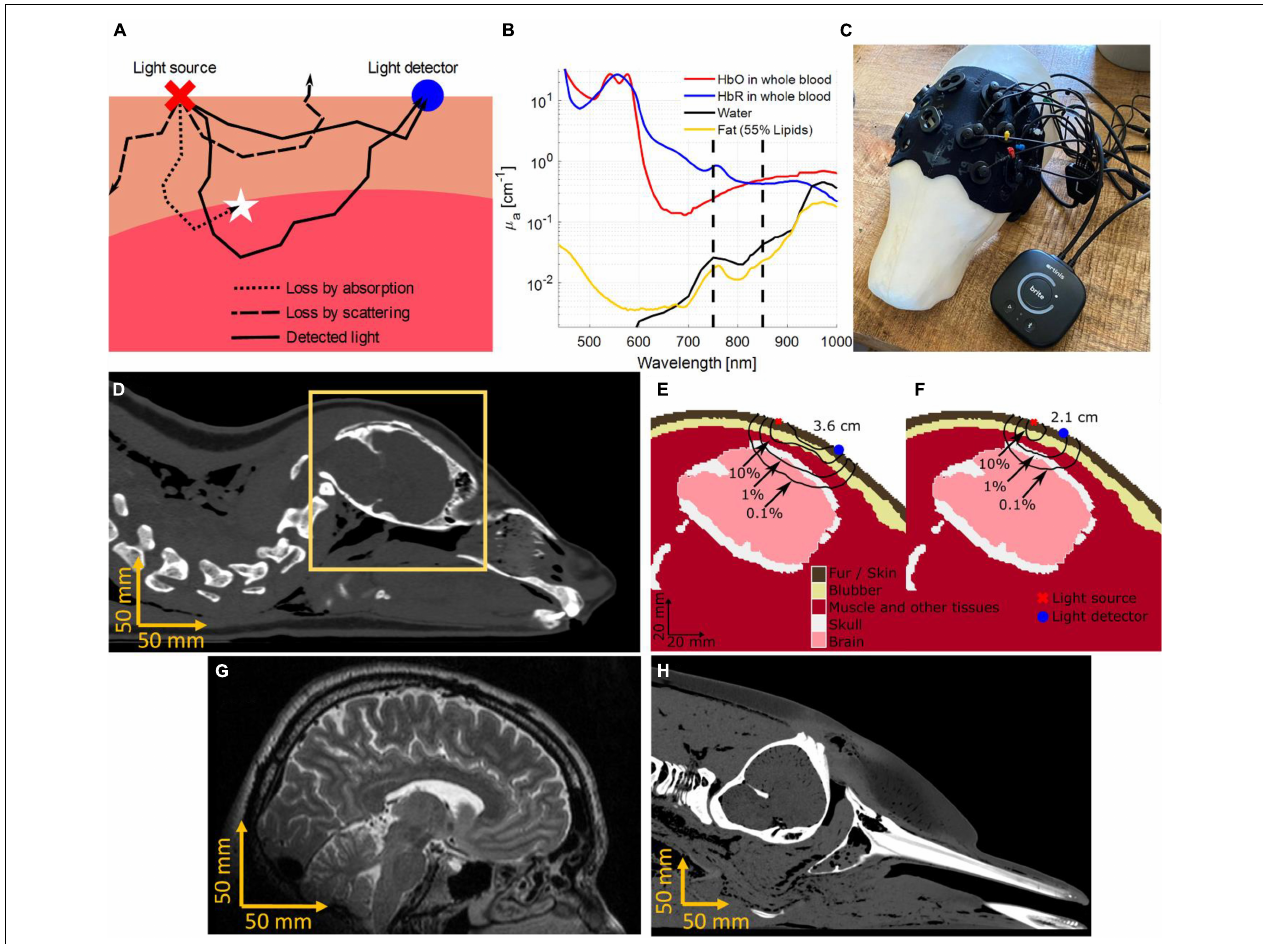
FIGURE 1 | The working principle of Near-Infrared Spectroscopy (NIRS). (A) Light interacts with molecules in biological tissue in two main ways, namely scattering and absorption. Scattering affects the direction of light progression, indicated by the black lines, making it possible for light to reach deeper into the tissue and return to the surface. Most scattered light is lost (dashed lines), however, a certain percentage of the light is scattered into the detector (solid lines). Additionally, some light loss can be attributed to absorption (dotted line). (B) The absorption spectrum of oxygenated (HbO) and deoxygenated (HbR) hemoglobin are shown under the assumption of 150 g of hemoglobin in 1 L of whole blood. Other common molecules present in biological tissue, such as lipids inside fat and blubber, as well as water emphasize the strong absorption of hemoglobin species for near-infrared wavelengths. Dashed lines indicate wavelengths at 750 and 850 nm, which are often used in medical, recreational, and research CW-NIRS devices. (C) The Brite NIRS device (Artinis Medical Systems, Elst, Netherlands) shown on a 3D model of a juvenile gray seal ( Halichoerus grypus ). The neoprene cap was custom fit for optimized optode placement around the brain. (D) The cross-section of a harbor seal ( Phoca vitulina ) computer tomogram (CT). (E) The orange window in panel (D) is segmented into optically relevant tissues. The black lines indicate the probability density of light received at a detector 3.6 cm away from the source (McKnight et al., 2019, 2021b). (F) The shorter source detector distance (2.1 cm) has a lower percentage of photons returning from the brain tissue but will in return receive more light. (G) A magnetic resonance image (MRI) showing the distance from the scalp to the brain in an adult human. (H) A CT scan of a stranded bottlenose dolphin, showing a much longer distance to the brain as compared to humans and harbor